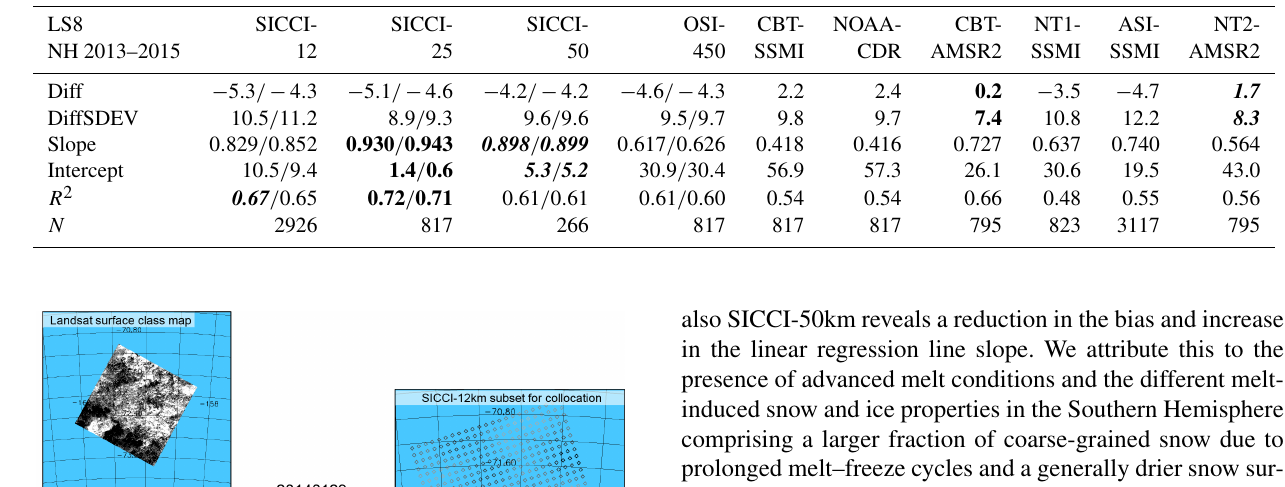
Table 12. Summary of statistical results obtained for 15 melt-condition cases (without melt ponds) in the Northern Hemisphere. See Table 5 for an explanation of the parameters shown. Numbers added to the right of the “/” for SICCI-2 and OSI-450 products denote the results obtained using non-truncated SIC.